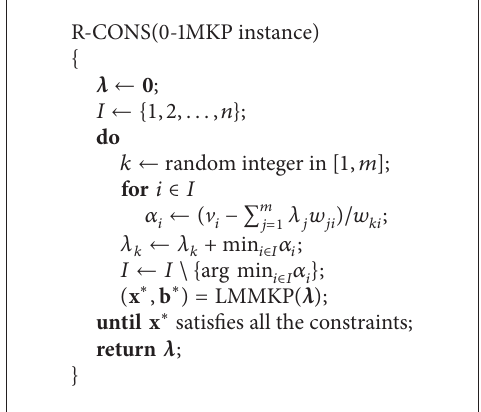
Algorithm 1: Randomized constructive heuristic [13, 19].